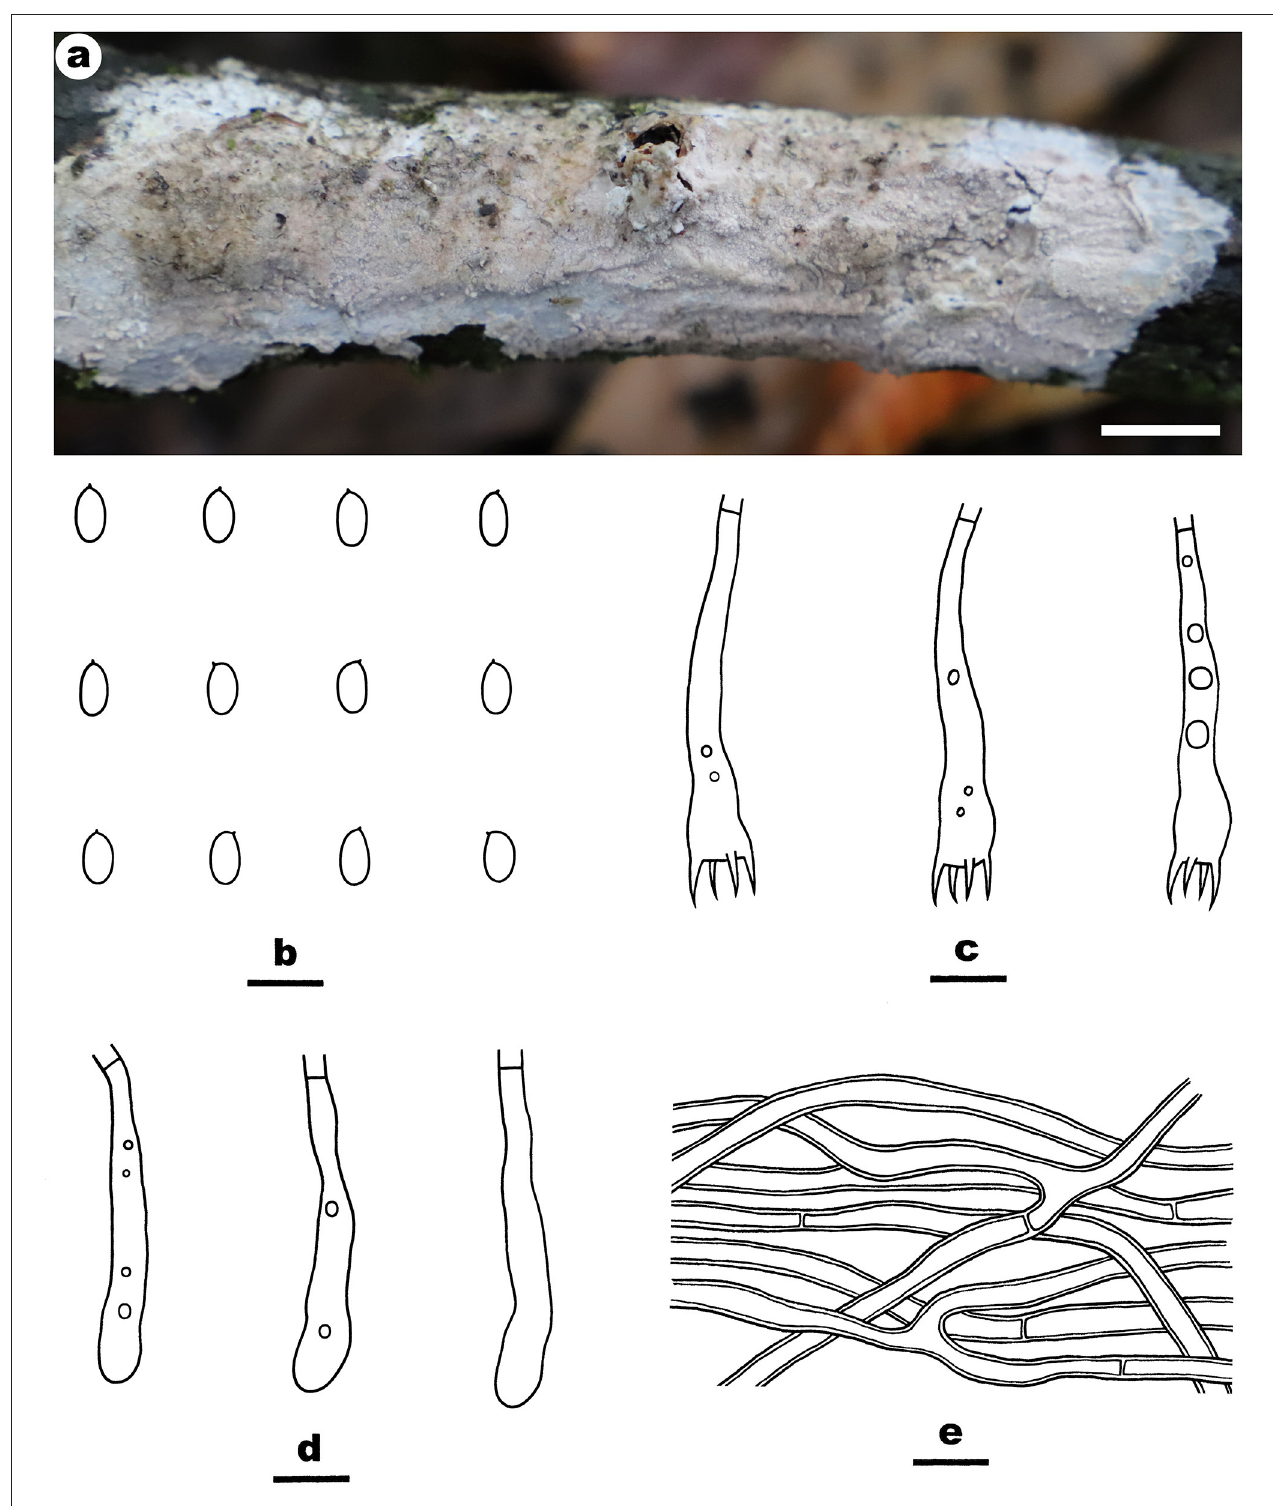
FIGURE 3 | Efibula grandinosa (from the holotype He 6312; scale bars: a = 1cm; b–e = 10 µ m). (A) Basidiomata. (B) Basidiospores. (C) Basidia. (D) Basidioles. (E) Hyphae from subiculum.